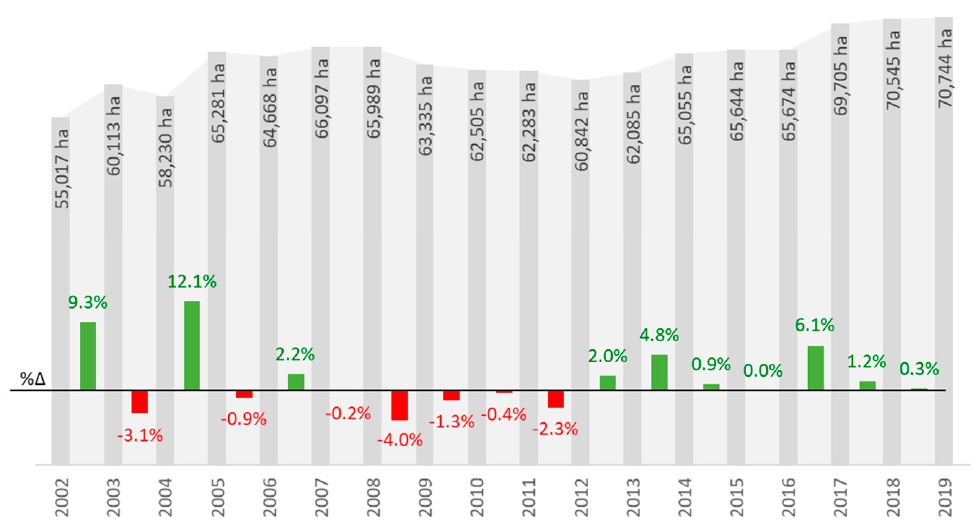
Figure 2. Crop production area under greenhouse (primary y axis) and interannual growth rate (% ∆ in secondary y axis) in Spain between 2002 and 2019